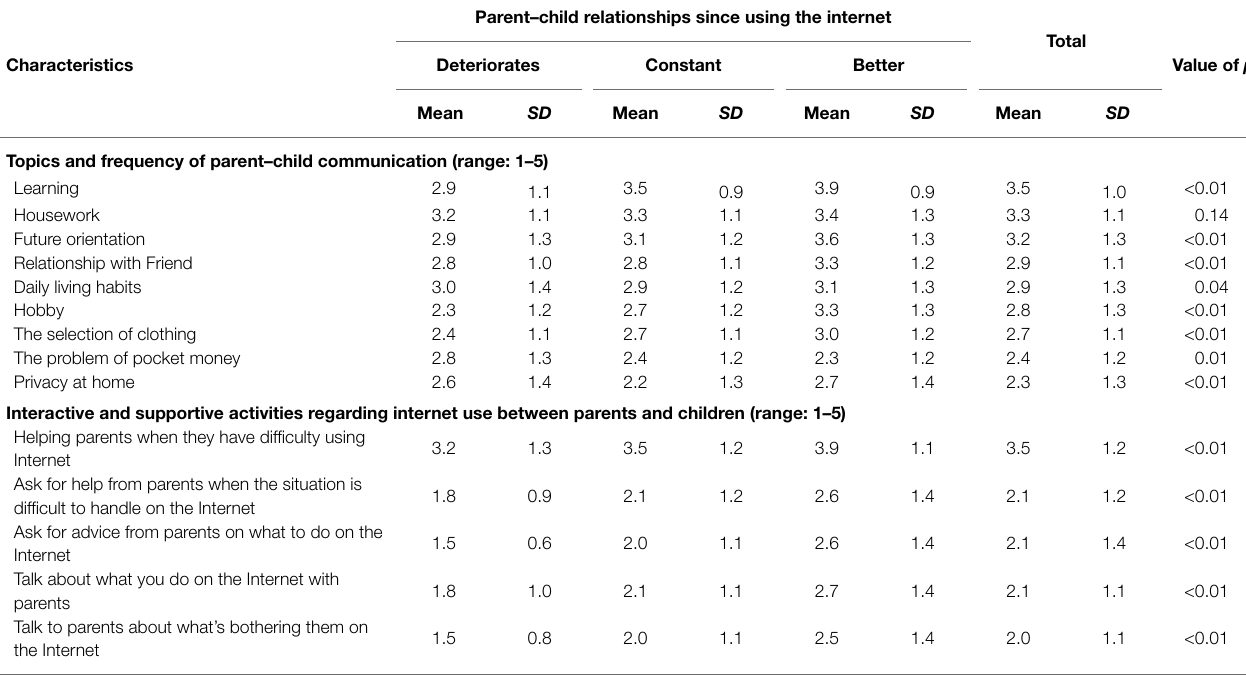
TABLE 2 | Topic, frequency communication and interactive activities regarding internet use between parents and children. Parent–child relationships since using the internet Characteristics